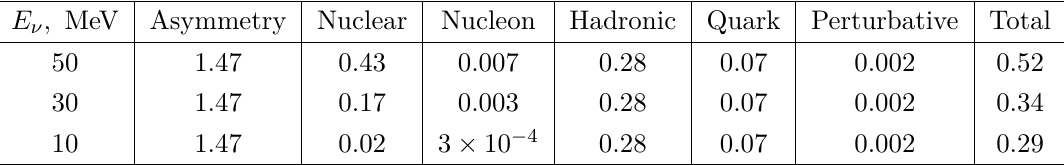
Table 4 . CE ν NS flavor asymmetry, ( σ ν relative error (in % ) for an incident neutrino energy E